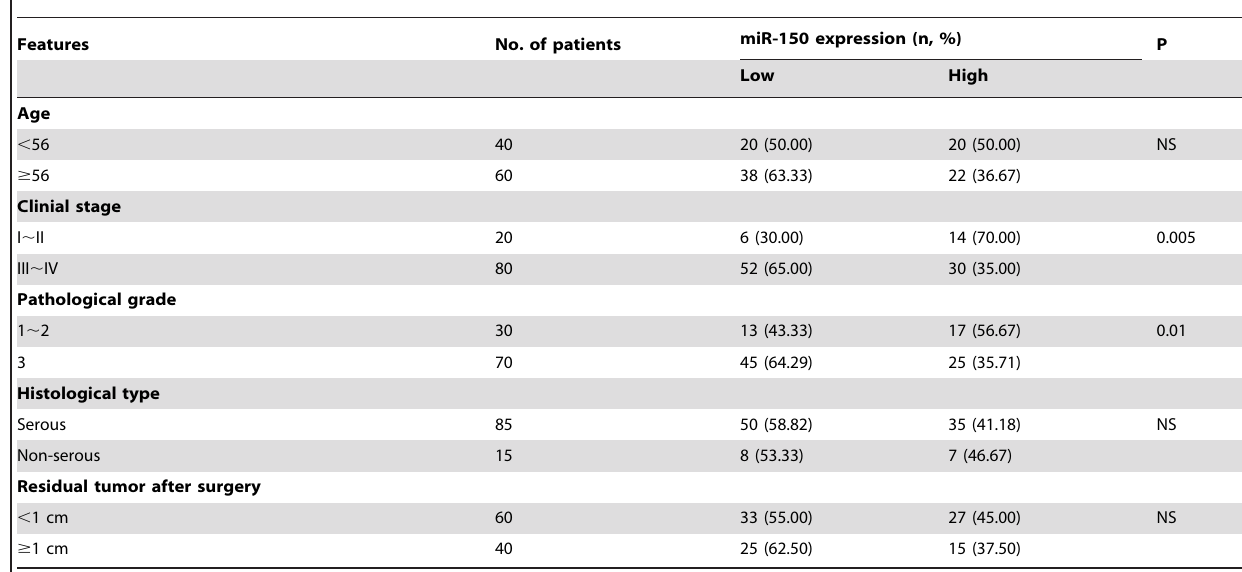
Table 1. Association of microRNA-150 (miR-150) expression with clinicopathological features of epithelial ovarian cancer tissues.